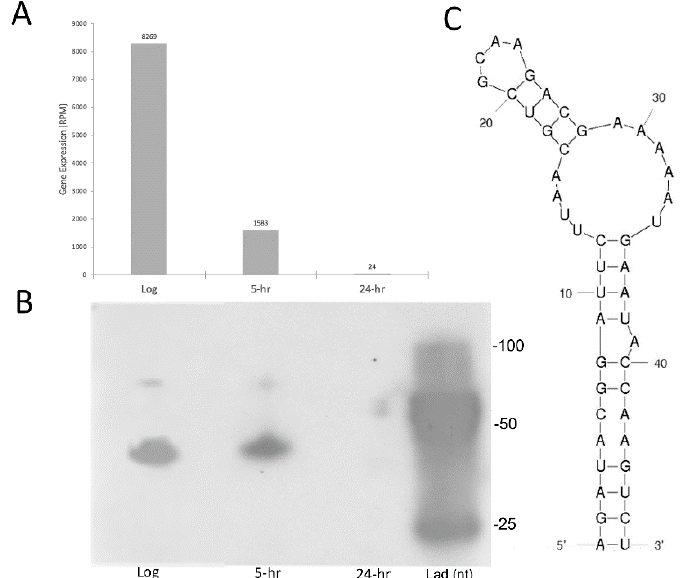
Figure 2. Northern blot validation of sRNA differential expressions. ( A ) The gene expression of sRNA4372453 depicts a decrease in expression from non-starved log phase to 24 h C-starvation. ( B ) Small transcript northern blot of sRNA4372553. Lad (nt), oligonucleotide ladder with band sizes indicated to the right. Log, log phase. 5-h, 5 h C-starved. 24-h, 24 h C-starved. ( C ) Predicted secondary structure [21] of sRNA4372453.